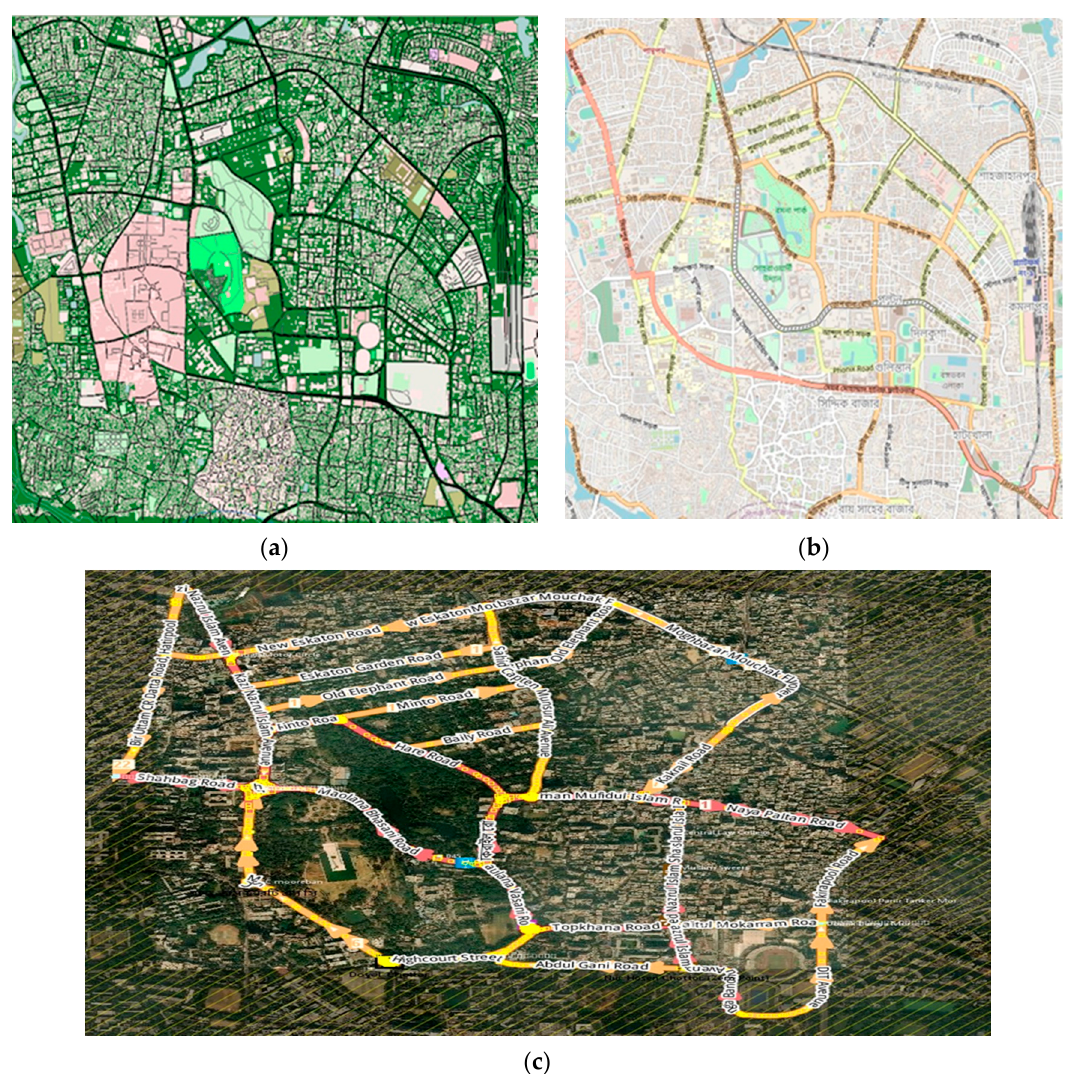
Figure 4. Map of the simulated area in Dhaka, Bangladesh: ( a ) SUMO software view of our simulated area. ( b ) OpenStreetMap view of our simulated area. ( c ) actual geographical view of our simulated